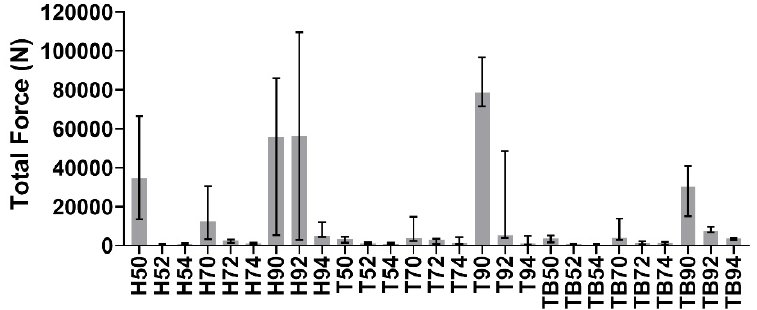
Figure 6. Medians and variability interval of the sum of peak forces measured during the removals.